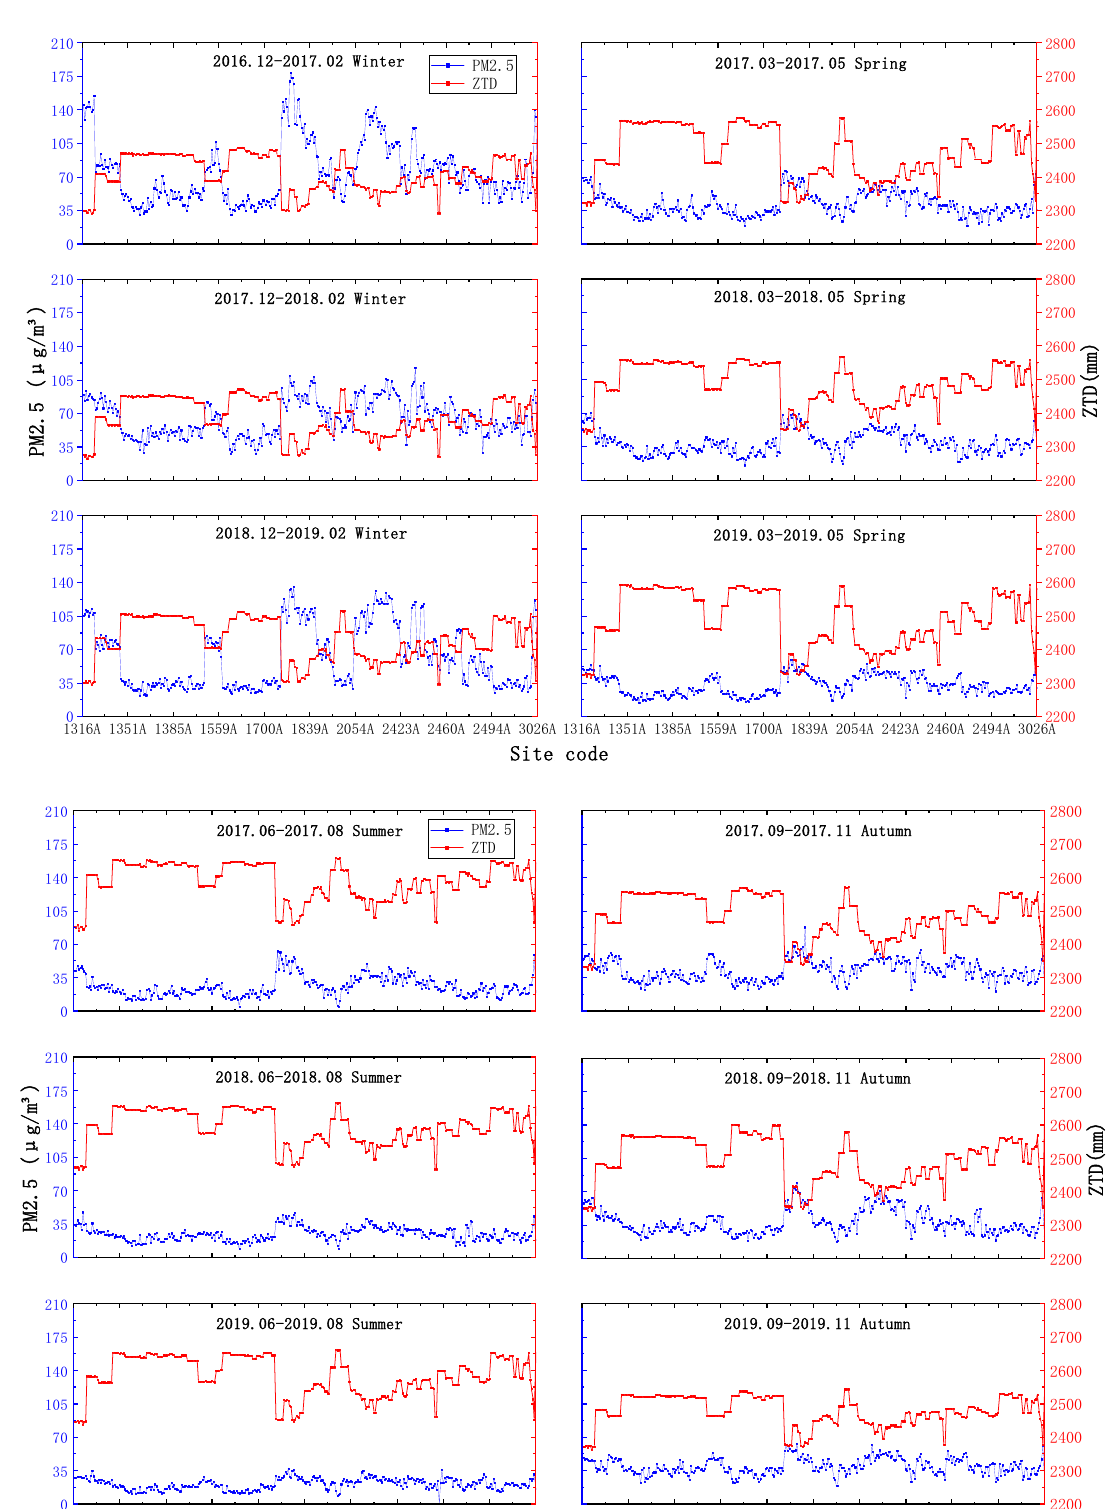
mean scale. The overall trends of PM 2.5 and ZTD at the seasonal mean scale are consistent with the negative-correlation phenomenon observed at the annual mean scale.